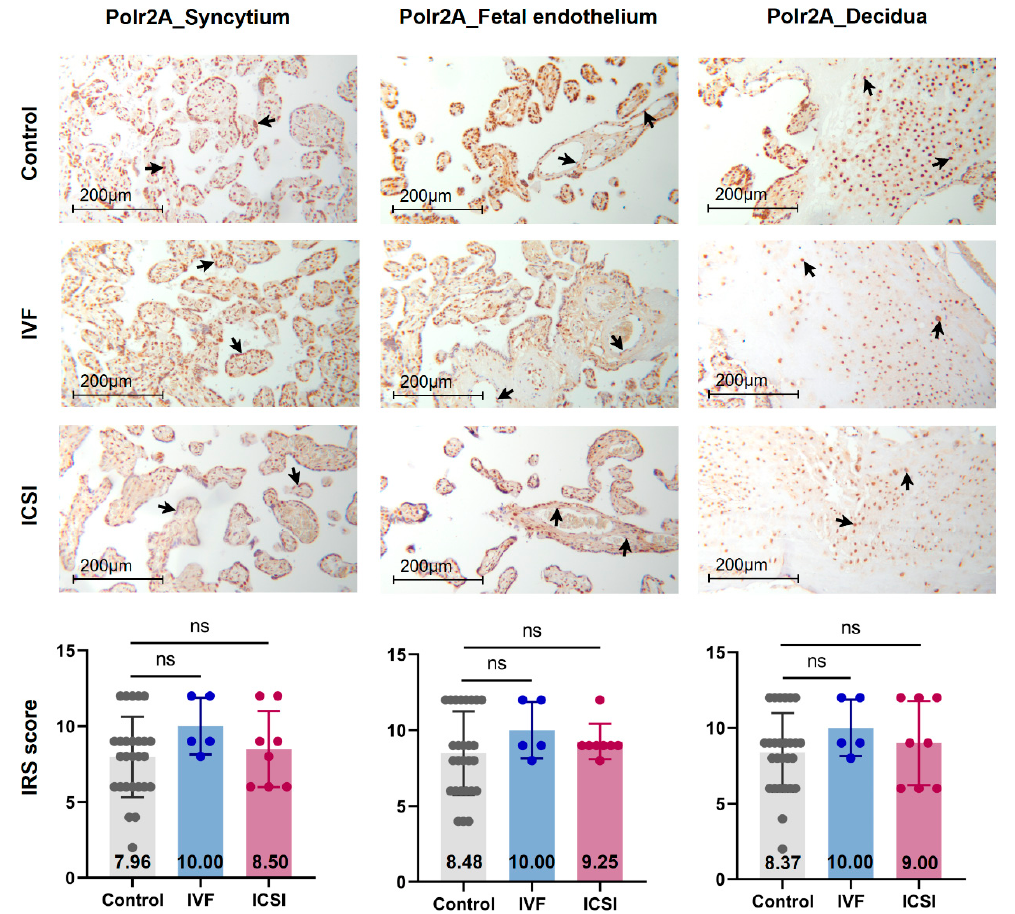
Figure 5. Polr2A expression showed no significant difference among natural conception, IVF, and ICSI-derived placentas. Polr2A levels showed no significant difference among groups. Boxplots showing the IRS distribution among natural con- ception ( n = 27), IVF ( n = 5), ICSI ( n = 8) groups along with significance levels indicated as p -value of the Mann-Whitney U -test. IRS = staining intensity × percentage of positive cells. Data were reported as mean ± SD. The arrows in the first, second, and third columns respectively pointed towards syncytial trophoblast cells, foetal endothelial cells and extravil- lous trophoblast cells. The numbers inside the columns represented the mean value of the corresponding IRS.